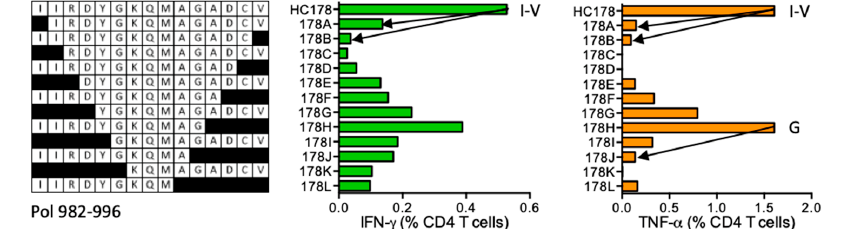
Figure 19. HC178/VID 403—definition of CD4 + T-cell epitopes in HIV-1 protein Pol. HC178 STCLs from subject 403 were tested against shorter peptides (left) in the ICS assay for IFN- γ (green) and TNF- α (orange) production. Arrows and amino acids I, V and G indicate the stimulatory peptide termini. HC190 LLRAIEAQQHLLQLT (gp160 746–760) the shorter peptides LLRAIEAQQHLL (LL12), LLRAIEAQQHL (LL11), LRAIEAQQHLLQLT (LT14), and IEAQQHLLQLT (IT11) (Figure 20), which are not reported as HLA class II binding epitopes. HC190 was predicted to bind DRB1*01:02, while the binding preference for peptide core LLRAIEAQQ is predicted for DRB1*04:01.